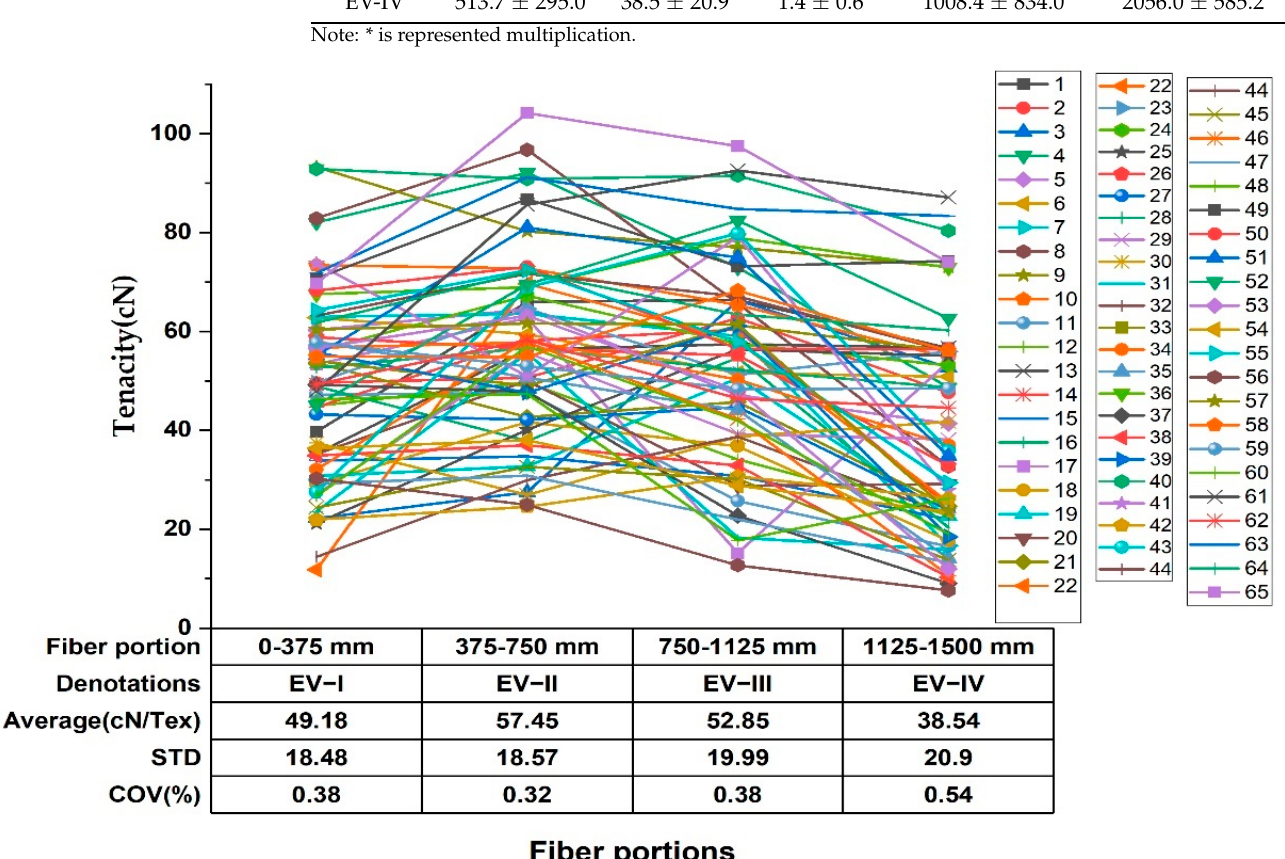
Figure 4. Enset bundle fiber sections versus tensile strength. Enset fibers show a brittle behavior with a sudden load drop when fiber failure occurs [30]. The characterization of the force–strain curve can be characterized into two regions, as shown in Figure 6. The first non-linear region is observed in the initial stage of loading, the deformation of every cell wall. The behavior may be described by the sliding of the microfibrils along with their progressive alignment with the fiber axis. This can be observed in Figure 6 in the loading direction, and it is conceivable that they would organize themselves so as to be as parallel as possible to the fiber axis. This alignment would cause rearrangements in the core of the surrounding amorphous matrix. These reorganizations imply an elastic-visco-plastic deformation of the thickest cell